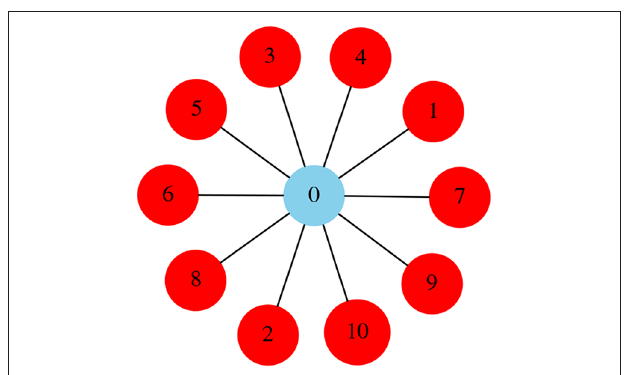
FIGURE 1 | Network 1: Star network composed of N = 11 nodes. The central node, also called hub, is colored blue, the peripheral nodes are colored red.